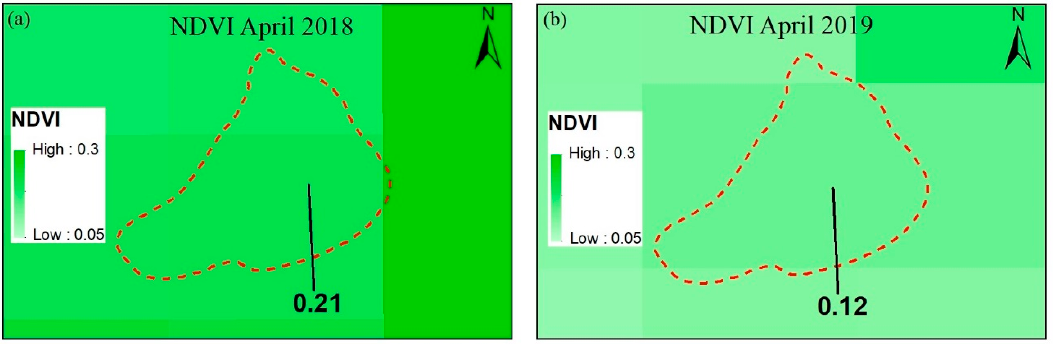
Figure 14. Comparison of NVDI values before and after landslide-accelerated damage. ( a ) NDVI value of landslide in April 2018; ( b ) NDVI value of landslide in April 2019.